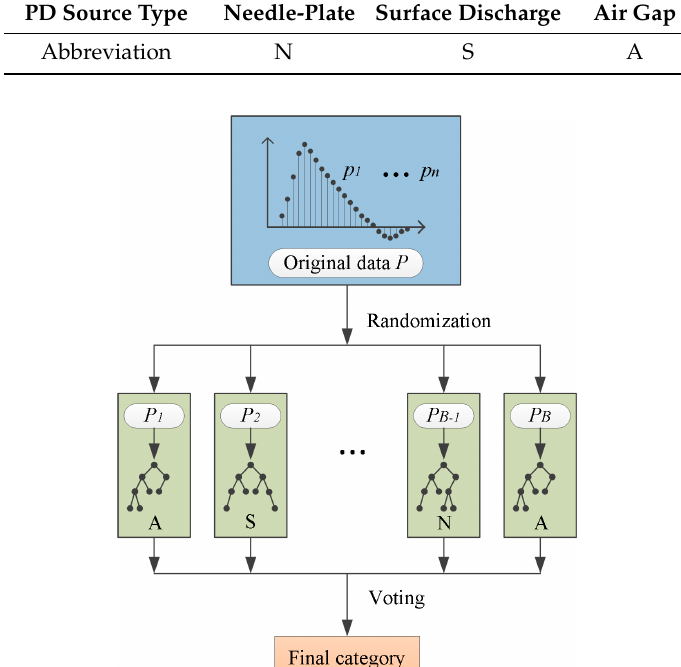
Table 2. Abbreviation of the source type.